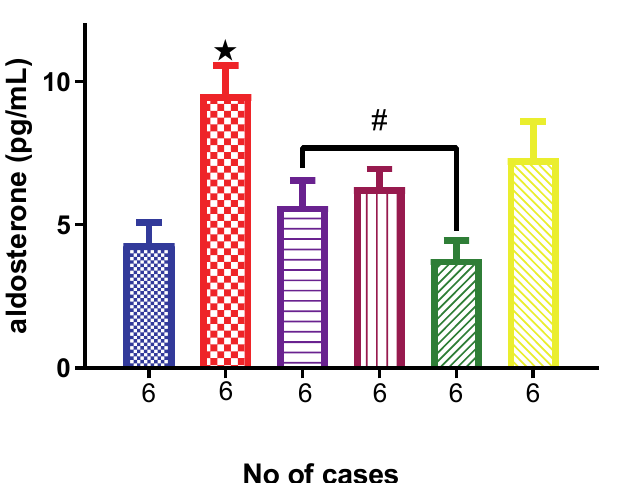
Figure 18. Plasma aldosterone concentration in normal control (NC), prediabetic control (PD), met- formin and diet intervention (MET + DI), metformin and high-fat/high-carbohydrate diet (MET + HFHC), rhenium (V) compound and diet intervention (Re + DI) and rhenium (V) compound and high-fat/high-carbohydrate diet (Re + HFHC) groups after 12 weeks of treatment. Values are pre- sented as means ± SEM (n = 6).